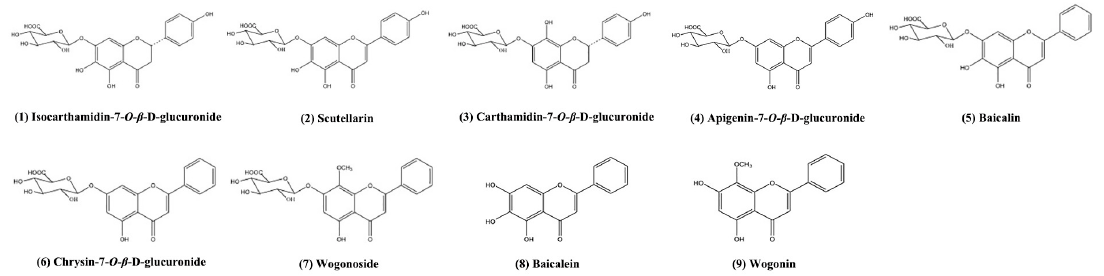
Figure 10. Structures of the quantified compounds. ( 1 ): Isocarthamidin-7- O- β - D -glucuronide; ( 2 ) Scutellarin; ( 3 ): Carthamidin-7- O - β - D -glucuronide; ( 4 ): apigenin-7- O - β - D -glucuronide; ( 5 ): Baicalin; ( 6 ): chrysin-7- O - β - D -glucuronide; ( 7 ): Wogonoside; ( 8 ): Baicalein; ( 9 ): Wogonin.